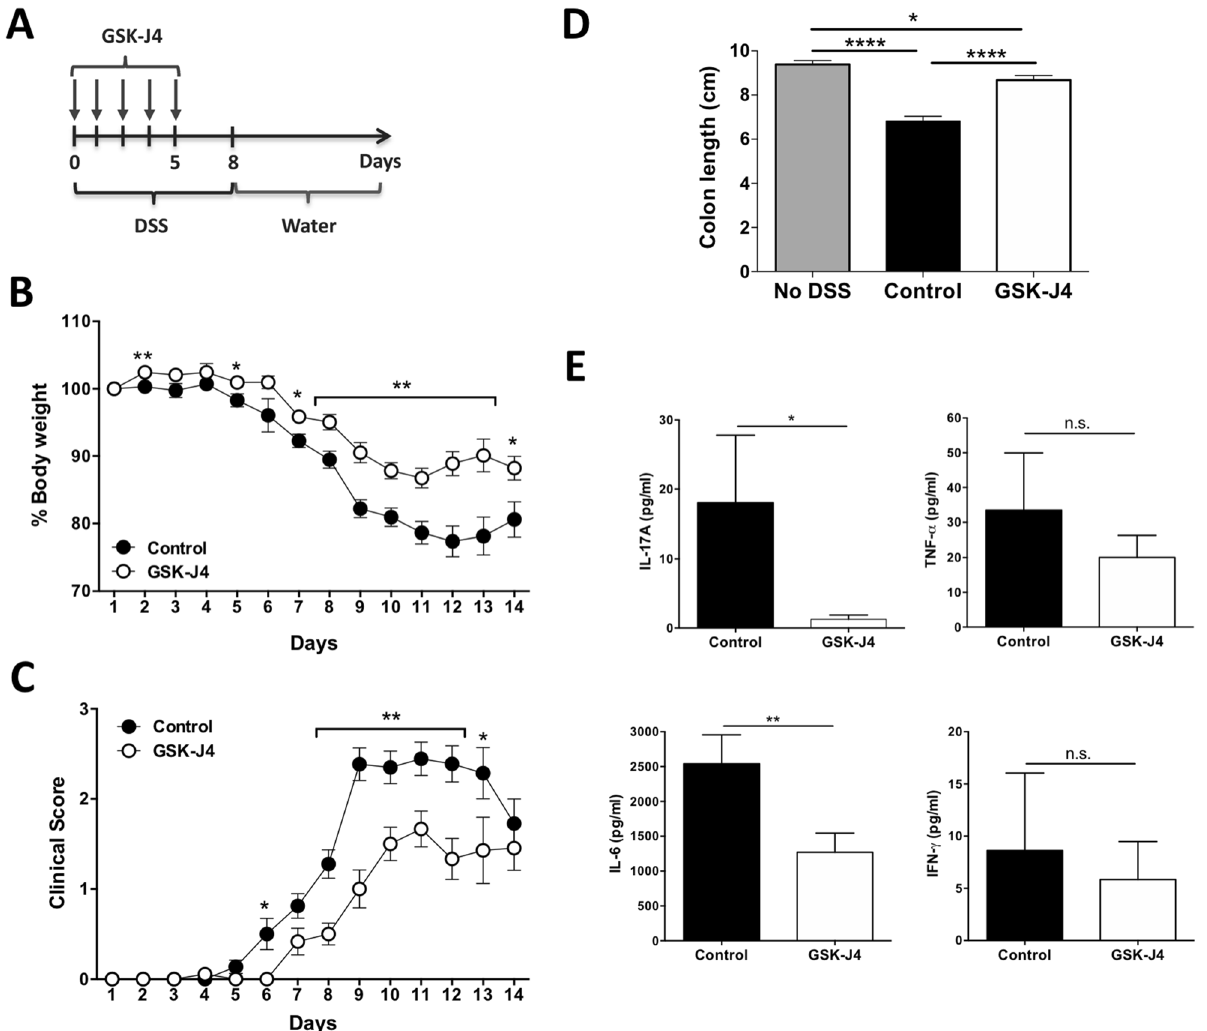
Figure 1. GSK-J4 treatment ameliorates DSS-induced acute colitis. Colitis was induced in C57BL/6 mice by the administration of 1.5% DSS. Vehicle or GSK-J4 (1 mg/kg) was administered daily for 5 days starting the same day DSS treatment began. ( A ) Scheme illustrating the experimental design. ( B ) Bodyweight change respect to the initial weight was calculated throughout the time-course of disease development. ( C ) Clinical score throughout the time-course of disease development. ( D ) Colon length of each experimental group determined on day 14 after colitis induction. ( B – D ) Values represent mean ± SEM from 18–22 ( B , C ) or 11–12 ( D ) mice per group. ( E ) At the peak of disease severity (day 12), mice were sacrificed and colon slices were cultured in fresh medium for 24 h and then the supernatant was evaluated for the secretion of IL-17, IL-6, TNFα, and IFNγ by CBA. Values represent mean ± SEM from 5 to 9 mice per group. * p < 0.05; ** p < 0.01; *** p < 0.001; *** p < 0.0001 as determined by Student’s t-test ( B , C , E ) or one-way ANOVA followed by Tukey’s post-hoc test ( D ). n.s., not significant differences were